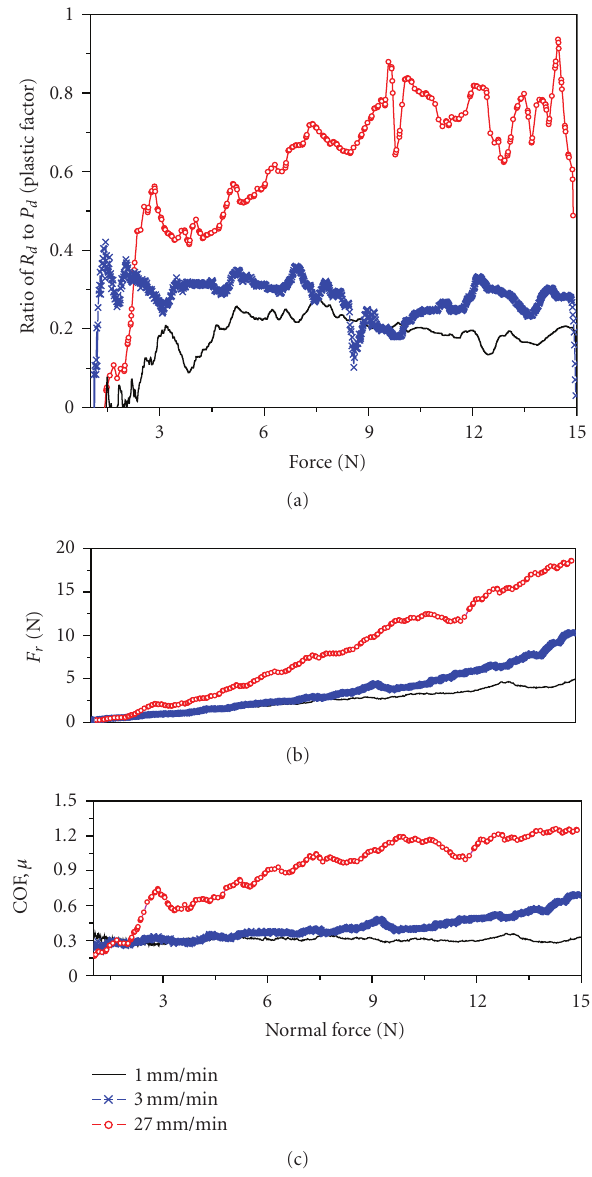
Figure 1: (a) The ratio of residual depth to penetration depth for progressive load ranging between 1 N to 15N at three di ff erent values of scratch speed v s = 1, 3, and 27 mm/min, (b) frictional force with progressive normal force acting on to the material SS AISI 304, and (c) the evolution of coe ffi cient of friction μ for scratch speed v s = 1, 3, and